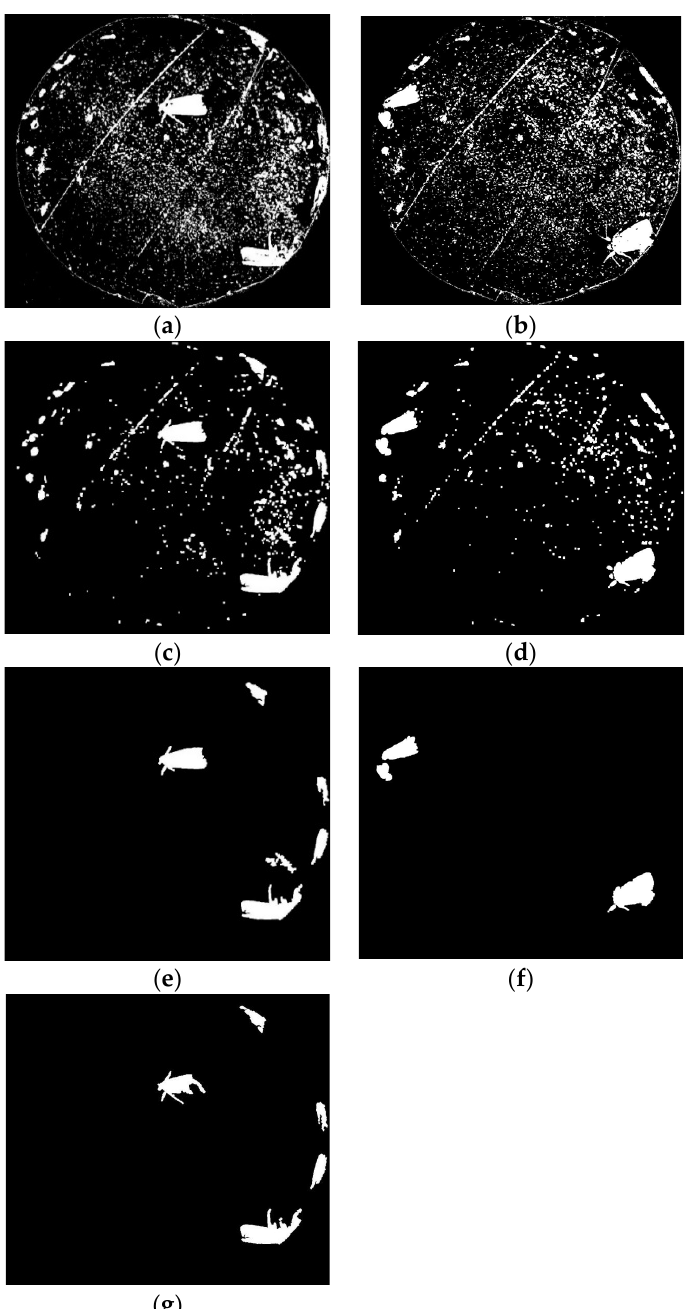
Figure 10. Image segmentation of S. frugiperda ( a ) The difference image obtained by subtracting the S. frugiperda binarization and background images. ( b ) The difference image obtained by subtracting the binarization image with S. frugiperda at the bottom edge of bucket and background images. ( c ) Image obtained after applying the Imopen operation. ( d ) Image with S. frugiperda at the bottom edge of bucket obtained after applying the Imopen operation. ( e ) Final image with light spot after elimination of small area interference. ( f ) The counting image result for S. frugiperda at the bottom edge of bucket obtained. ( g ) The counting image result of S. frugiperda after light spot removal.